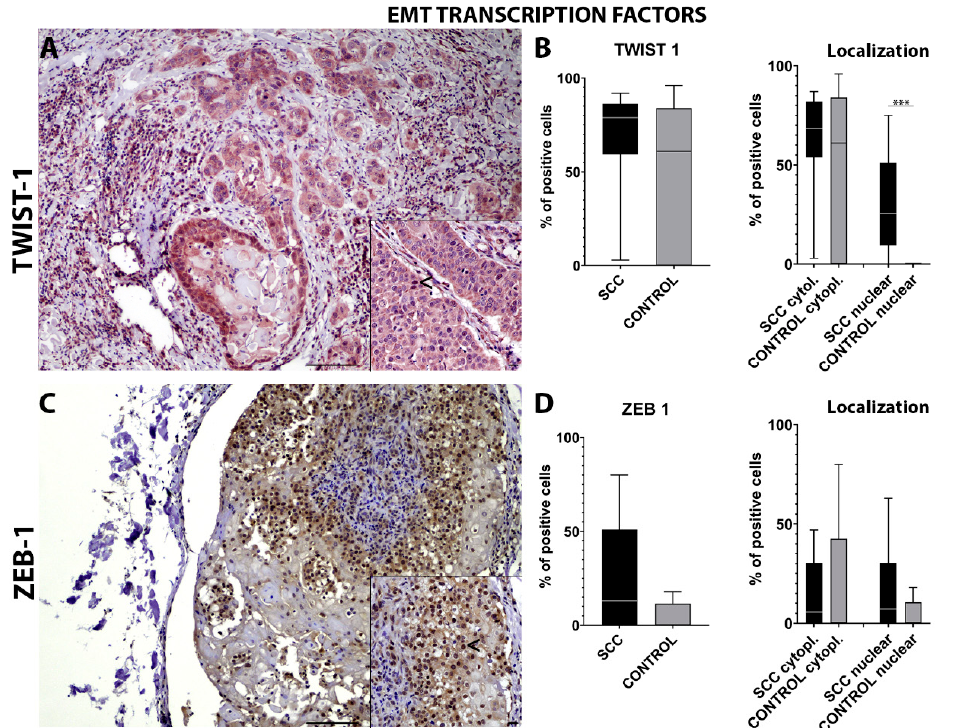
Figure 3. Immunohistochemistry for TWIST-1 ( A ) shows an occasional nuclear and cytoplasmic expression in the cells on the epSCC invasive front (<— A insert). Box-and-whisker plots show a higher number of cells immunolabeled for TWIST-1 in the epSCC samples ( B ). Box-and-whisker plots showing a higher number of cells expressing cytoplasmic and nuclear TWIST-1 in the epSCC samples ( B ). Immunohistochemistry for ZEB-1 ( C ) shows nuclear expression in the cells on the epSCC invasive front (<— C insert). Box-and-whisker plots show a higher number of cells immunolabeled for ZEB-1 in the epSCC samples ( D ). Box-and-whisker plots showing control tissue with a higher number of cells expressing cytoplasmic ZEB-1 and epSCC with a higher number of cells with nuclear ZEB-1 expression ( D ). Scale bar = 100 µm and scale bar-insert = 20 µm. All graphs represent box-and-whisker plots with *** p ≤ 0.001. SCC: squamous cell carcinoma group; SCC cytopl: squamous cell carcinoma group cytoplasmic.